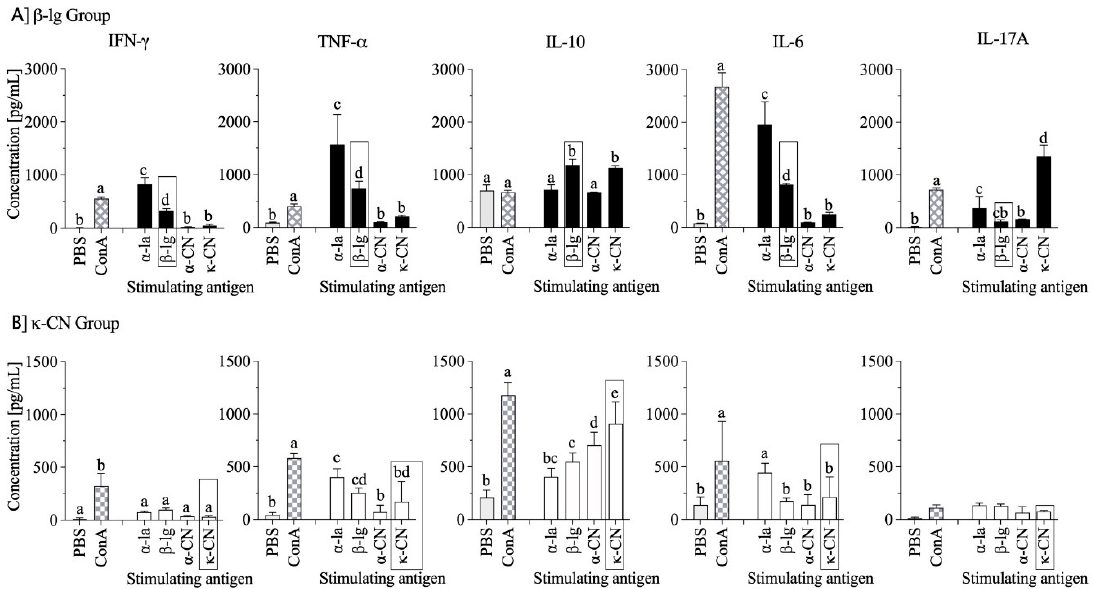
Figure 8. Cytokines secreted during splenocyte culture after ex vivo stimulation with different milk antigens (dose 200 µg/mL). Lymphocytes were isolated from mice immunized with β -lg ( A ) or κ -CN ( B ). Data are expressed as mean ± SD. Statistical analysis were performed with one-way ANOVA follow by Tukey’s post-hoc test. Means with different letters differ at p < 0.05.